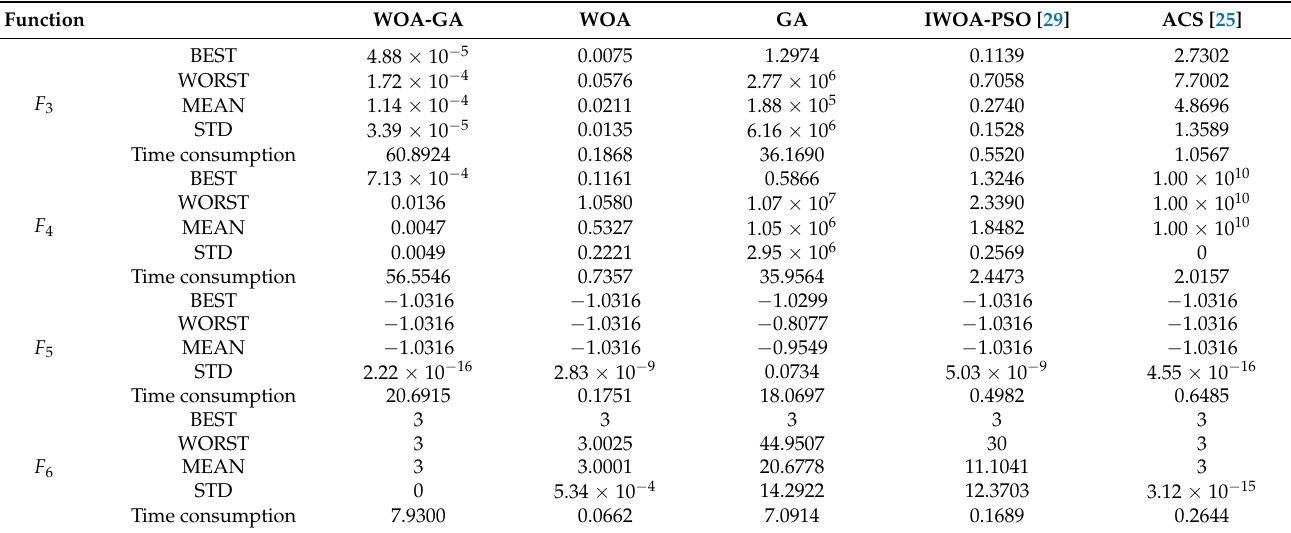
Table 6. Comparisons of the optimization results for the multimodal functions.